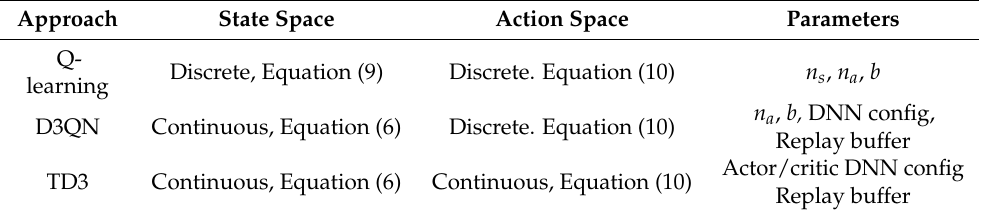
Algorithm 1 . Analyzer Initialization